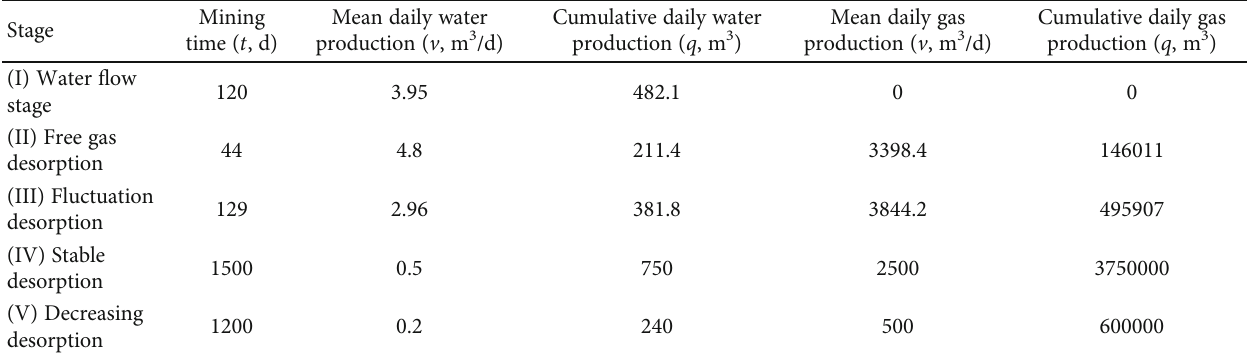
Table 1: Production of methane and water in No. 3 seam of 1# test well,